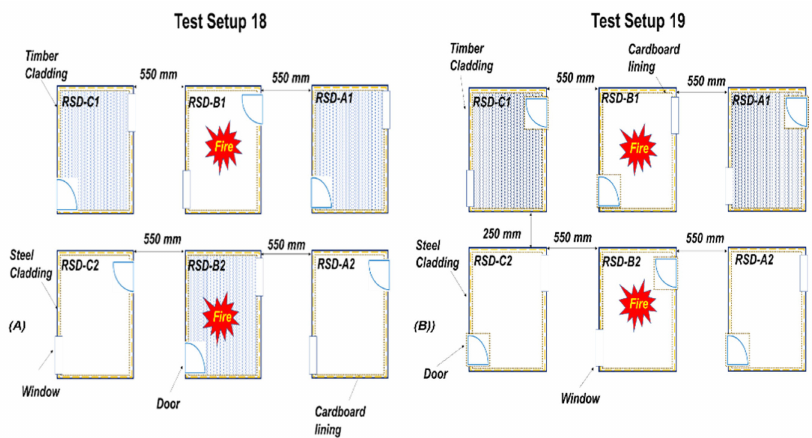
Figure 19. Six RSD experiment—( A ) test setup 18, ( B ) test setup